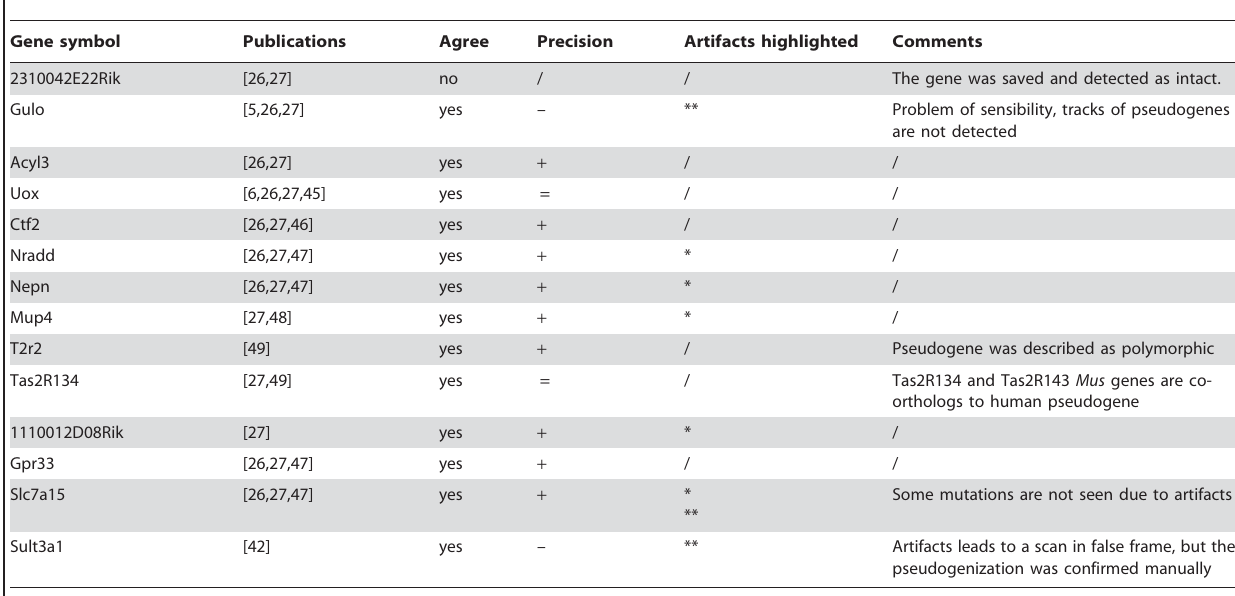
Table 1. Benchmark results of 14 pseudogenes cases described in literature.